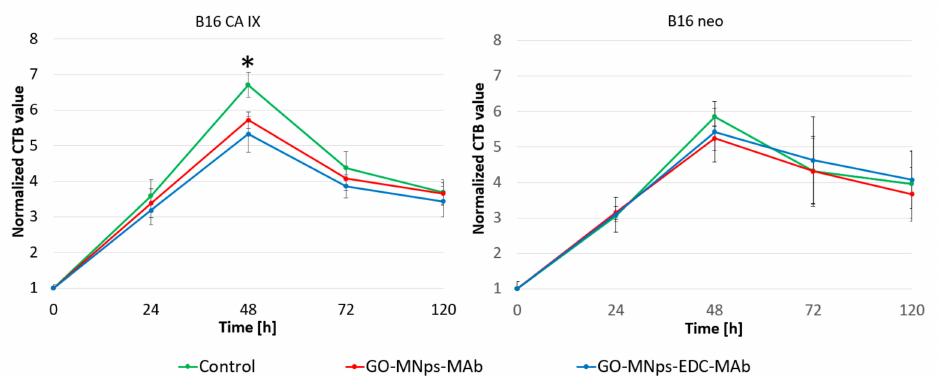
Figure 8. Viability testing of graphene oxide platforms with magnetic nanoparticles modified antibodies (GO-MNps-MAb) and graphene oxide platforms with magnetic nanoparticles modified antibodies in the presence of 1–ethyl–3–(3–dimethylaminopropyl) carbodiimide (GO-MNps-EDC-MAb) was performed on mouse melanoma cells (B16). Cell line was permanently transfected with full-length carbonic anhydrase IX (CA IX) cDNA. Control cell line was used (neo) without transfected CA IX cDNA. A significant di ff erence in viability of B16 CA IX cells between the control and samples after 48 h cultivation is marked by